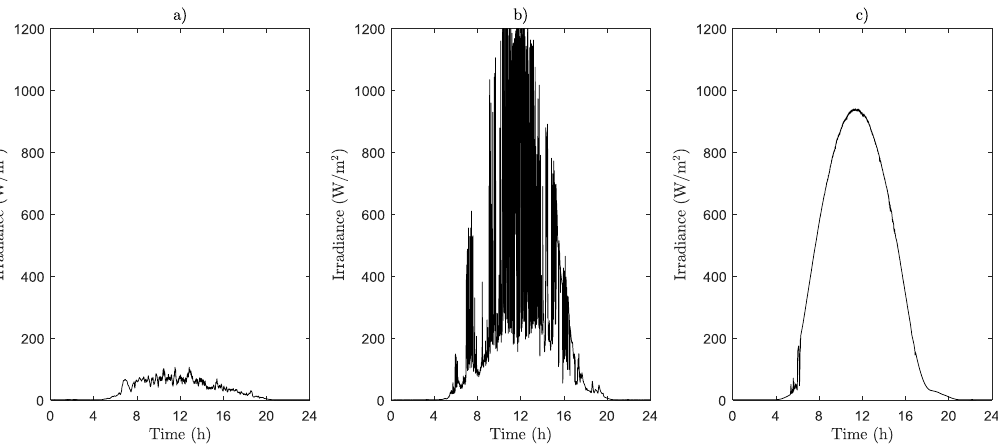
Figure 1. Irradiation measurements of one sensor on ( a ) 26th of April; ( b ) 23rd of April and ( c ) 12th of August in 2015.